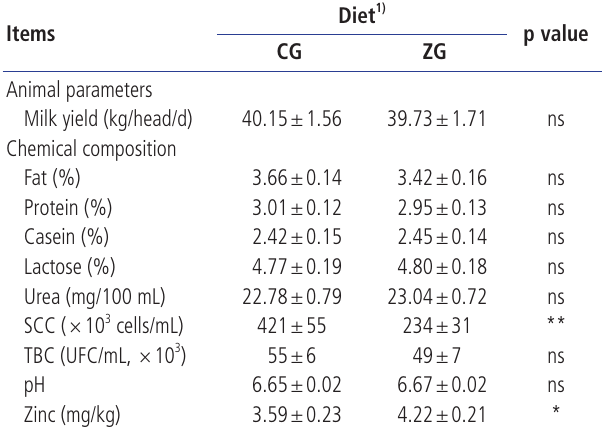
Table 2. Milk yield and chemical composition of milk obtained from the control and the experimental group Items